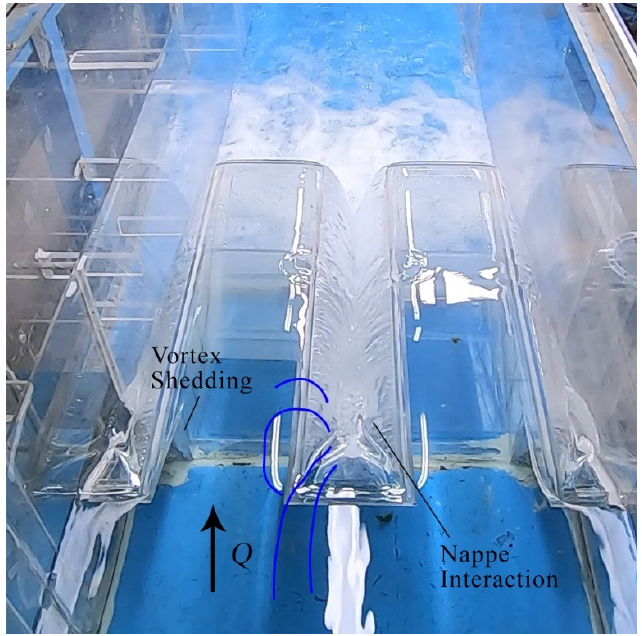
Figure 4. Type A PK weir ( W i /W o = 1.28) with flow field modification due to structure geometry and energy dissipated in part by outlet keys including upstream face and jet interaction.